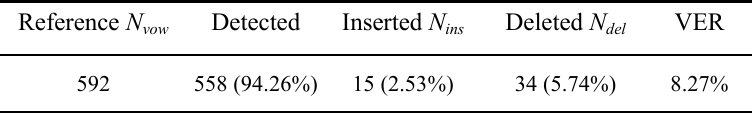
Table II: Prosogram’s performance compared with hand